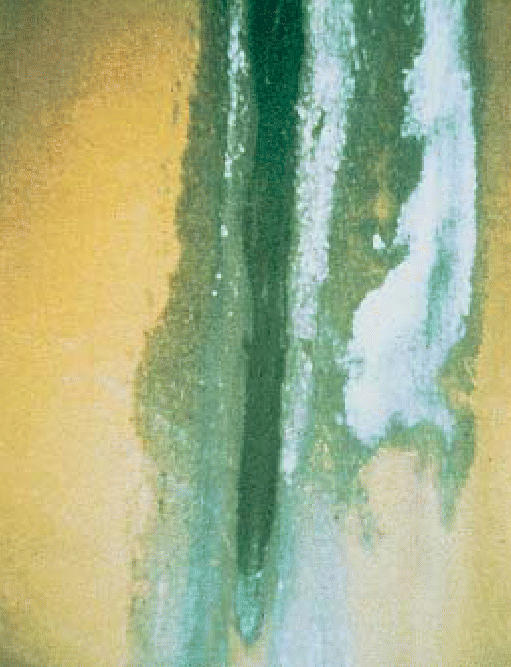
Eau de StachybotrysThe mold’s toxin kills olfactory neurons.